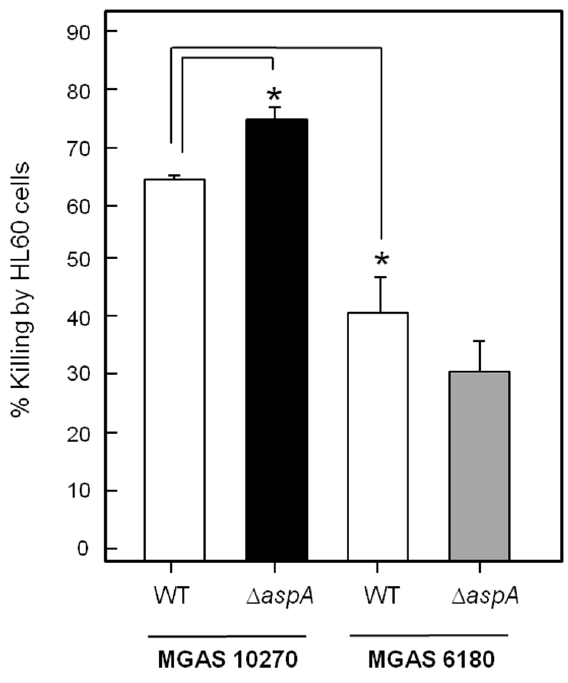
Figure 5. Percentage killing of S. pyogenes MGAS6180 or MGAS10270 wild type and aspA mutants by HL60 neutrophils following 1 h co-incubation as compared with controls. Percentage killing was calculated from cfu remaining compared with control samples without neutrophils (input 10 4 cfu, 10 5 neutrophils). Data are means 6 SEM of 5 experiments repeated in triplicate. *= P , 0.05 using 2 tail student T-test.